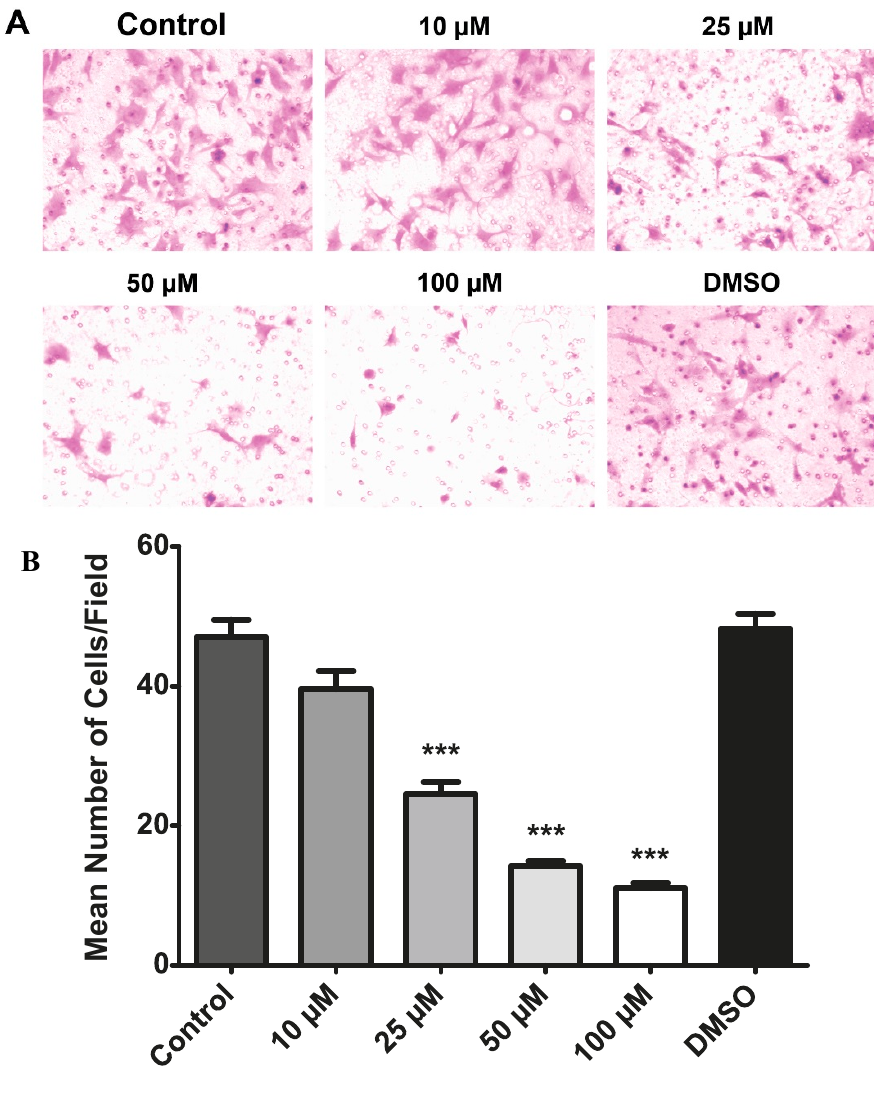
Figure 8. Resveratrol inhibits the migration of choroidal endothelial cells. A transwell assay was utilized to measure the number of cells migrating through a membrane with